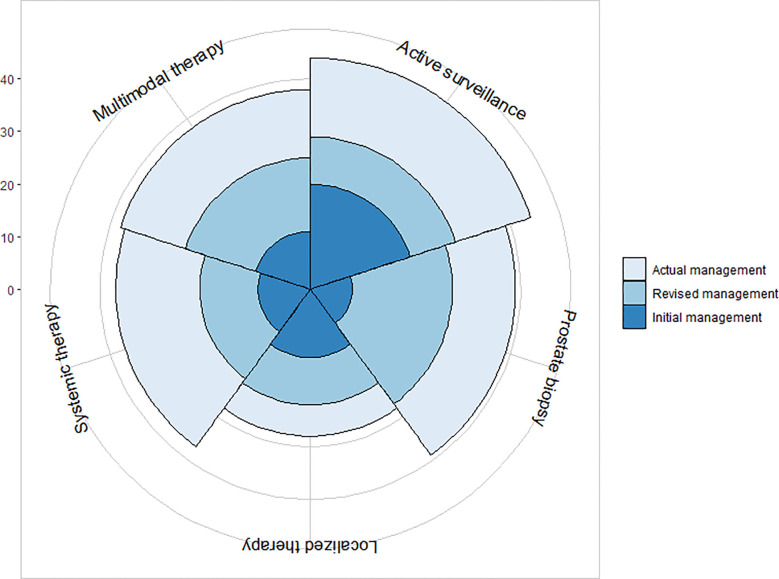
Rose diagram shows the distribution of managements before 18F-PSMA-1007 PET/MRI (initial management), after 18F-PSMA-1007 PET/MRI (revised management), and implemented management (actual management). Management decisions were categorized as active surveillance, prostate biopsy, localized therapy (surgery and salvageable pelvic radiotherapy), systemic therapy (anti-androgen therapy or chemotherapy), and multimodal therapy (more than one therapy type).